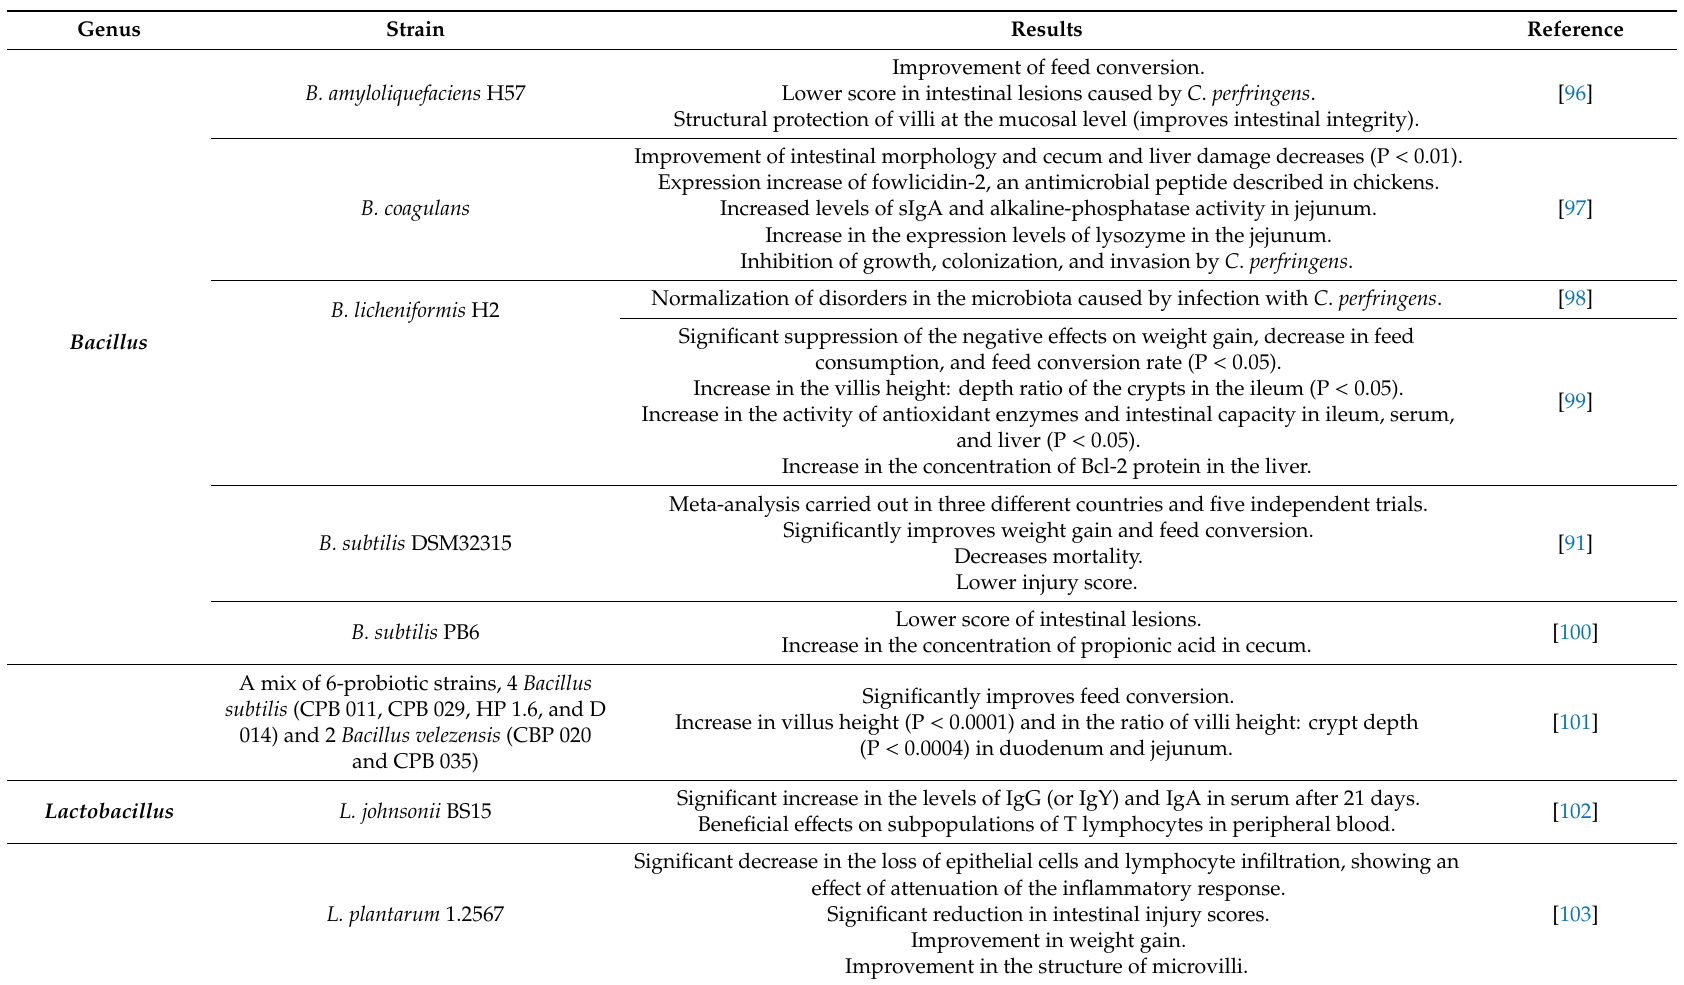
Table 5. Probiotics used in the treatment of necrotic enteritis caused by Clostridium perfringens in an avian model.